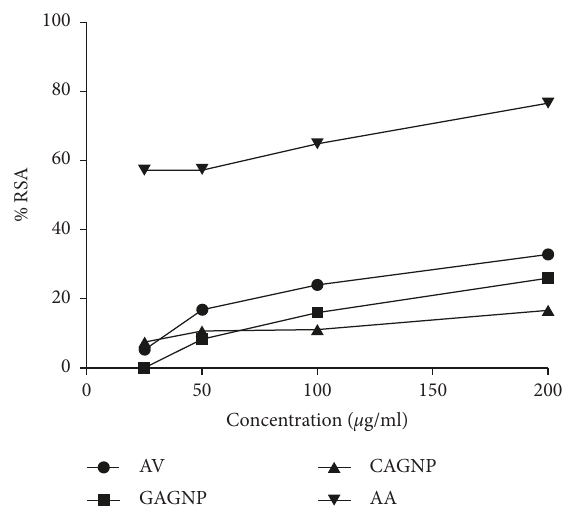
Figure 4: Free-radical scavenging activity of Aloe vera extract, AgNPs using Aloe vera leaf extract (GAgNPs), chemically syn- thesized AgNPs (CAgNPs), and ascorbic acid (AA). Te ability of Aloe vera extract, GAgNPs, CAgNPs, and AA (used as the reference antioxidant) to inhibit DPPH was estimated as a function of in- creasing concentration (from 50 to 200 μ g/ml) and by recording the decrease in absorbance at